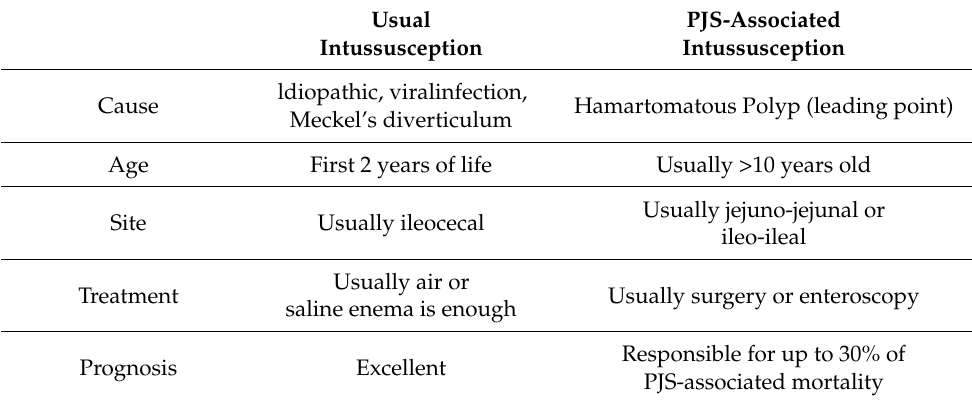
Table 1. Difference between usual and PJS-associated